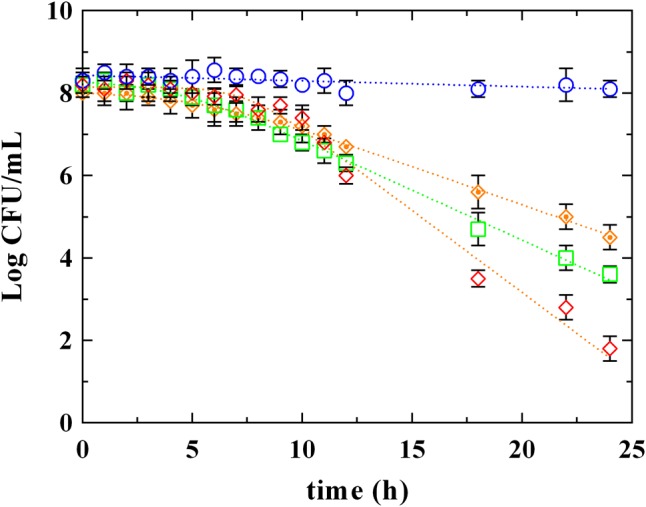
Survival of L. innocua ATCC 33090 in (∘) MES buffer (C), or in MES buffer containing: (♢), phenyllactic acid at MIC concentration detected at pH 5.5 (PLA_MIC); (□), lactic acid (LA) at MIC concentration detected at pH 5.5 (LA_MIC) or (), LA at the same concentration of MIC of PLA (LA_PLA). Symbols represent the mean values with standard deviation of three independent experiments and the curves represent the survival models obtained with GInaFiT software.